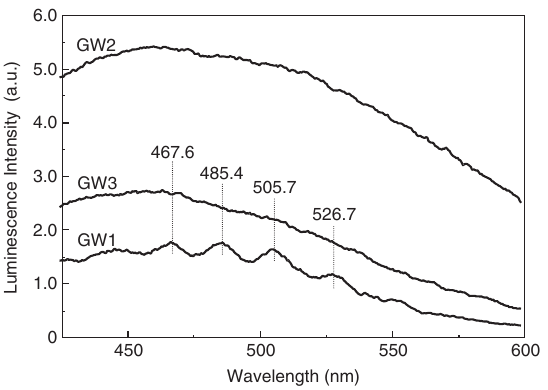
Figure 1 Time-resolved luminescence spectra for the raw ground- water samples listed in Table 1.